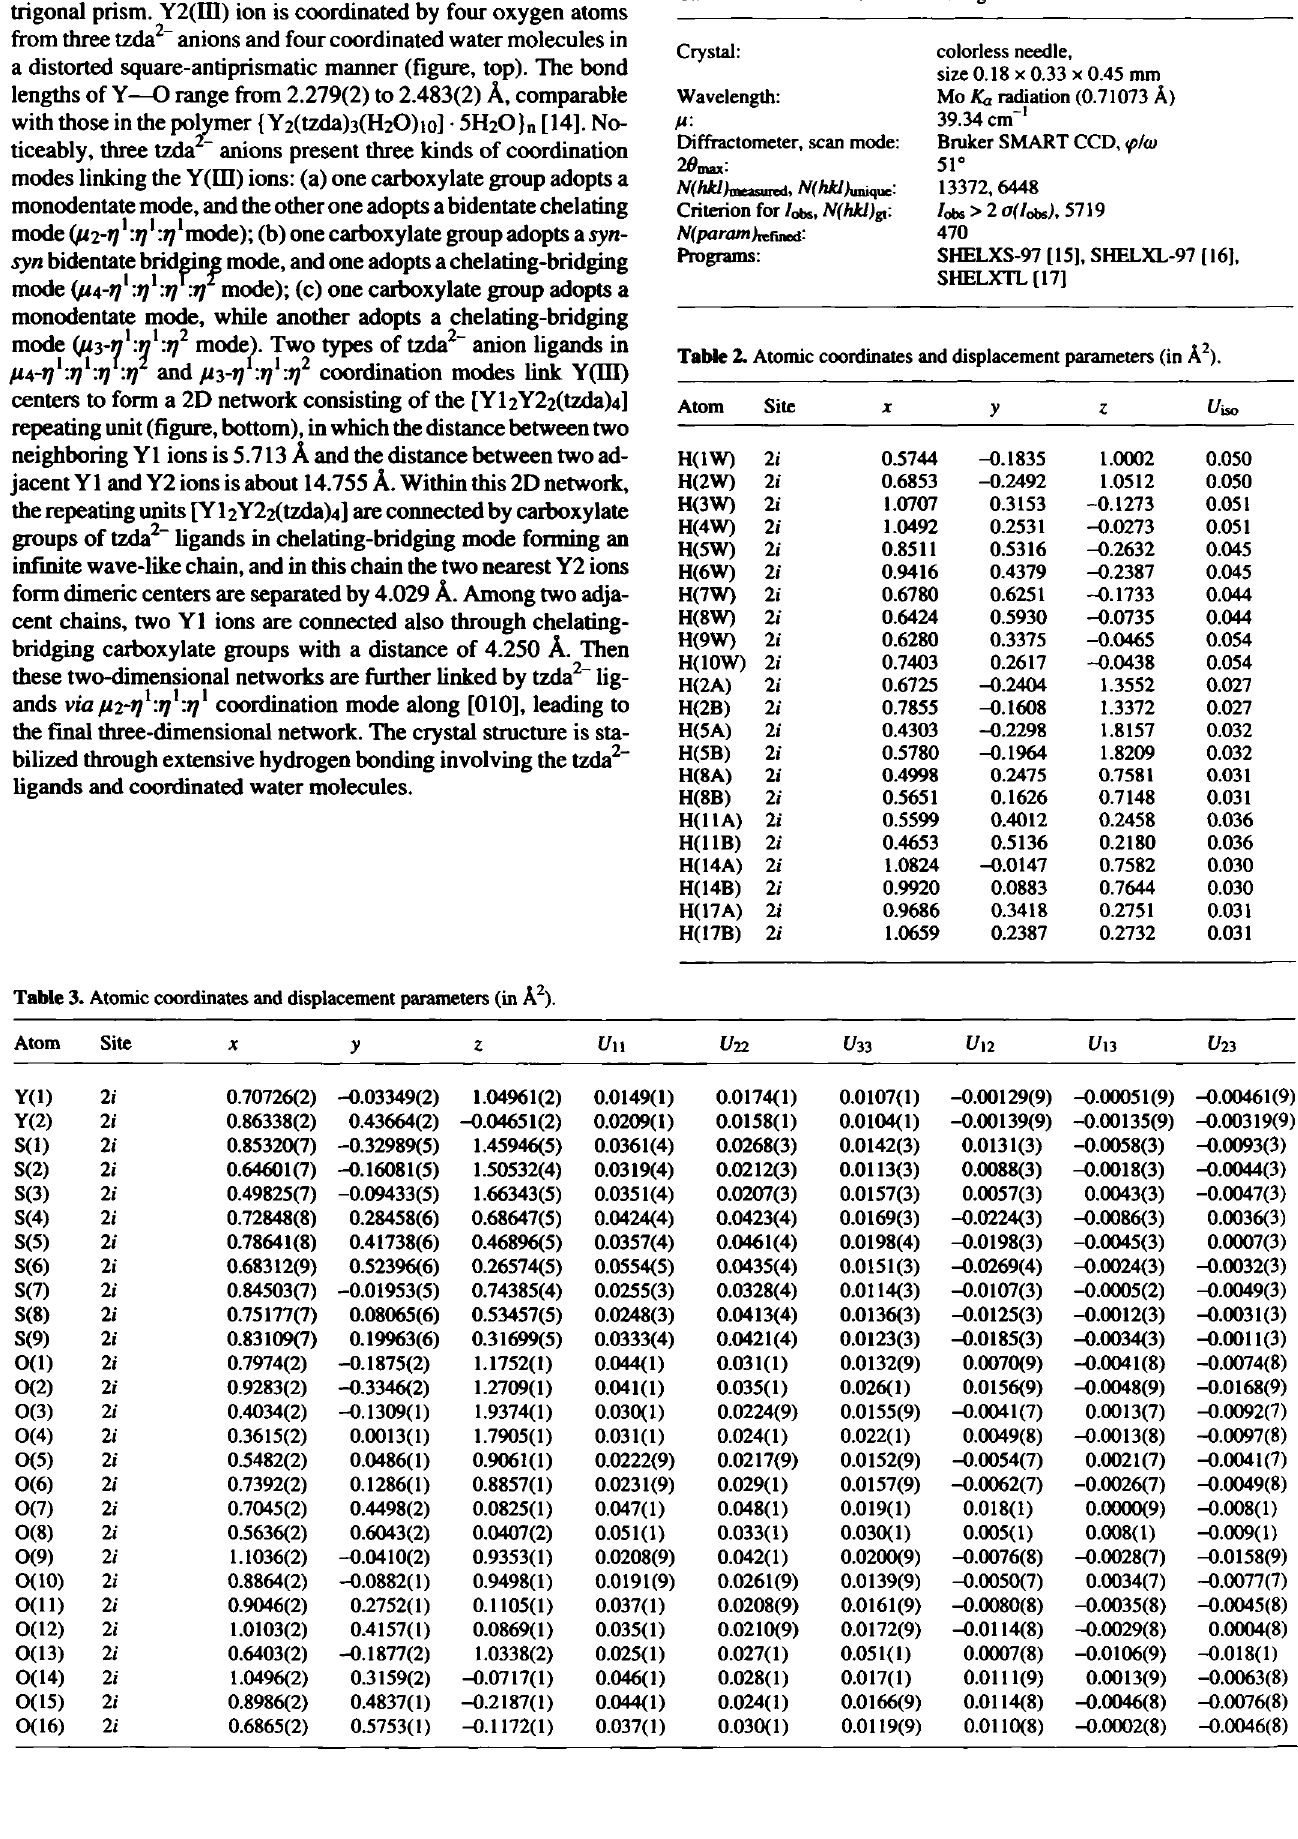
Table 1. Data collection and handling.